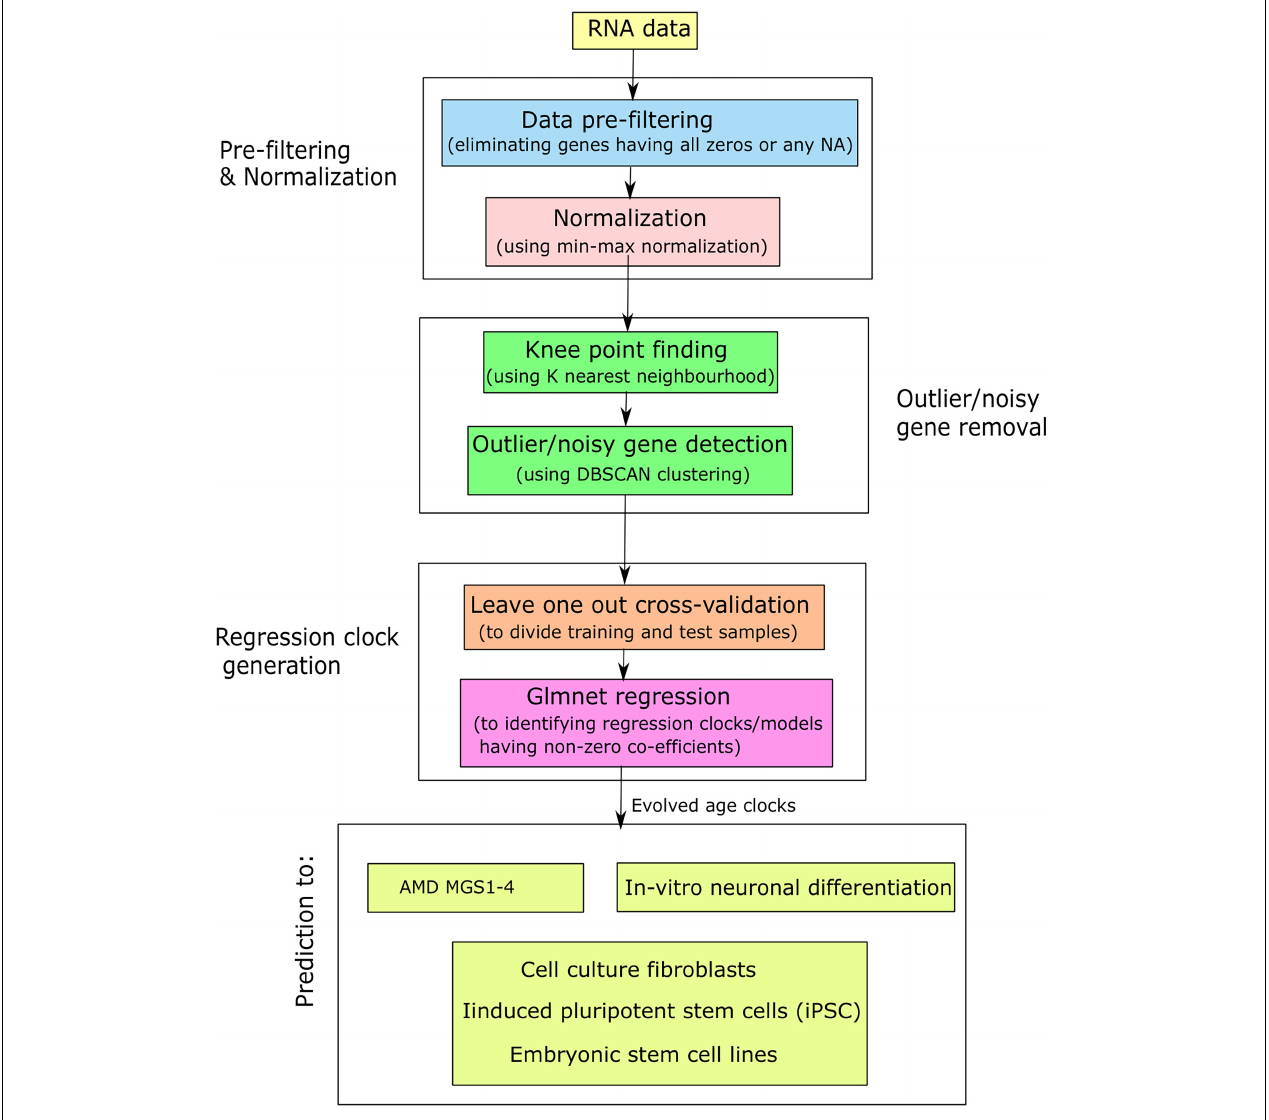
FIGURE 1 | Simplified flowchart for the generation of aging clocks and their application in AMD and related